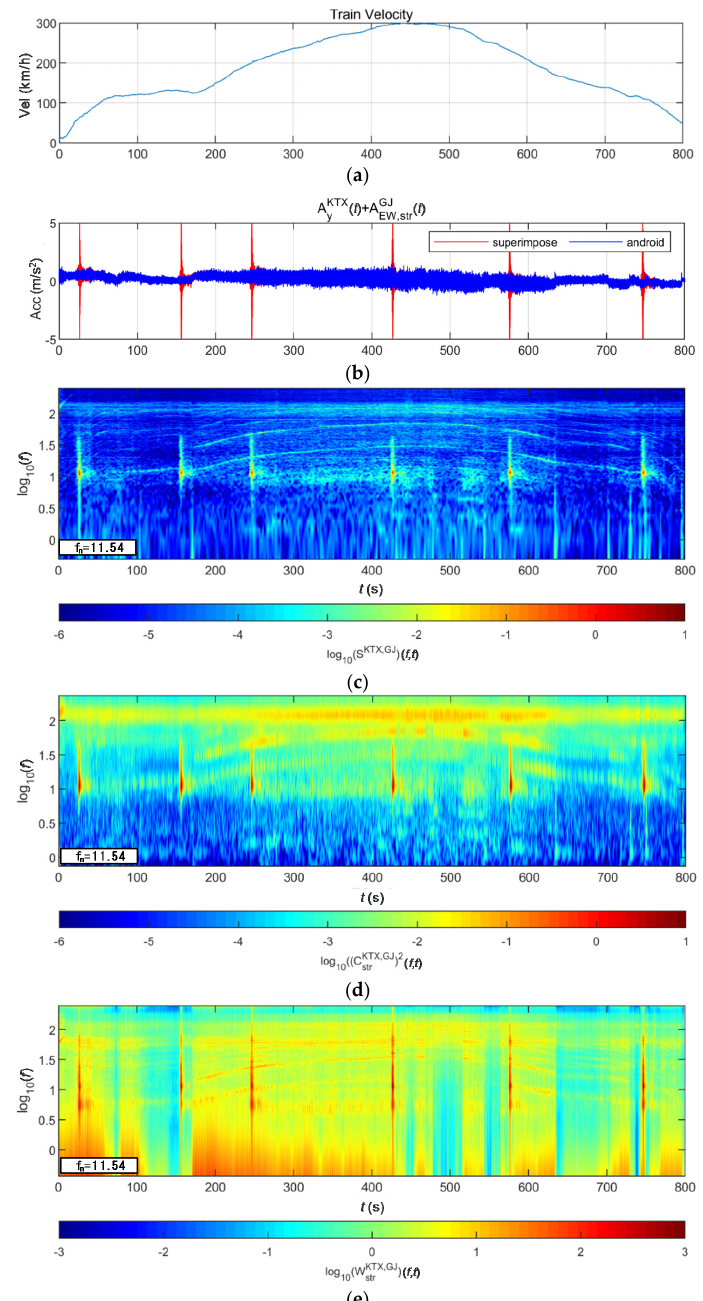
Figure 29. Combination of train data with BR2 bridge-response data from the Gyeongju earthquake (scaled to 2400-year return period): ( a ) velocity; ( b ) lateral acceleration time series; ( c ) STFT; ( d ) WT; ( e ) WVD.